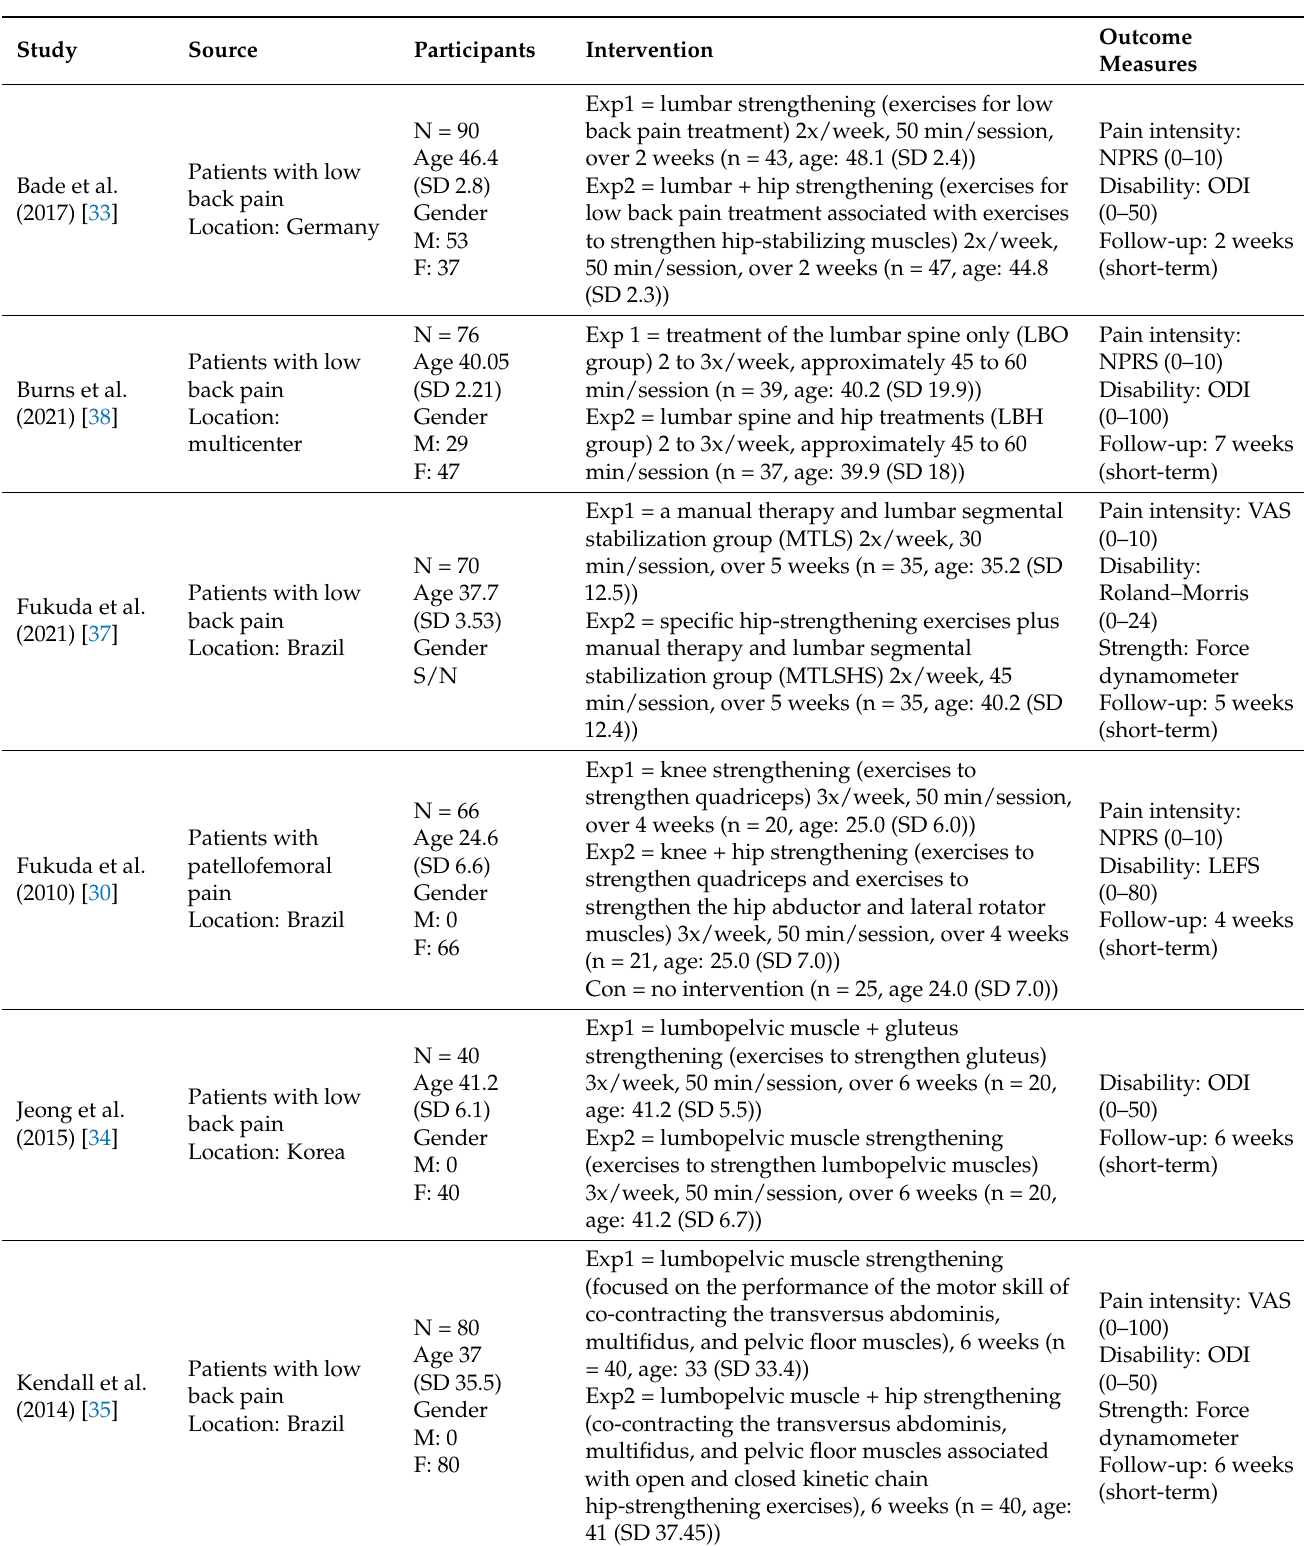
Table 1. Characteristics of the included trials (n =